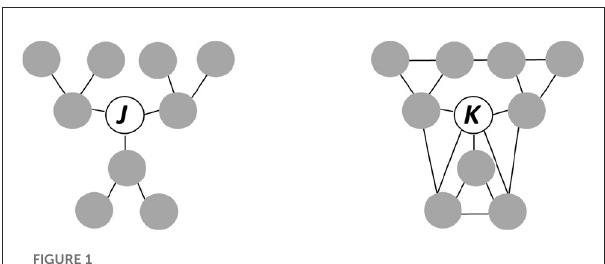
FIGURE1 The difference between individual and collective social capital.